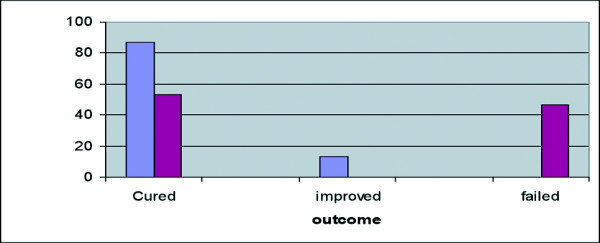
Immunochemotherapy of PKDL. Patients received either 40 daily injections of 20 mg/kg/day Sodium Stibogluconate (SSG) alone, or SSG plus 4 weekly injections of alum-ALM+BCG. Cured = complete disappearance of lesions (not including discoloration or scar).